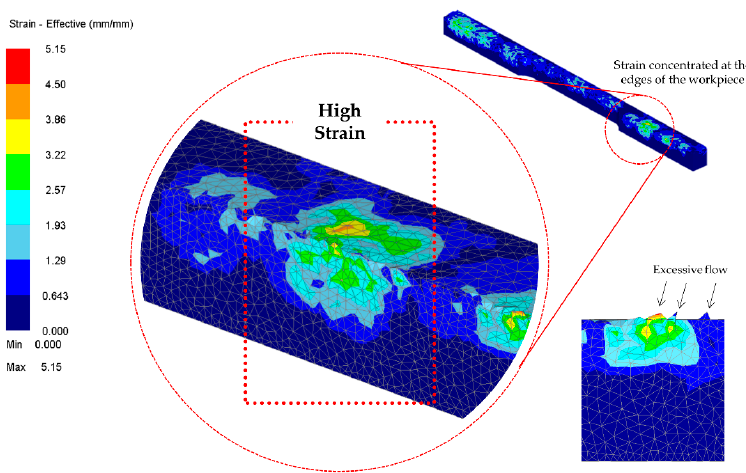
Figure 8. Strain concentration on the edges of the workpiece.